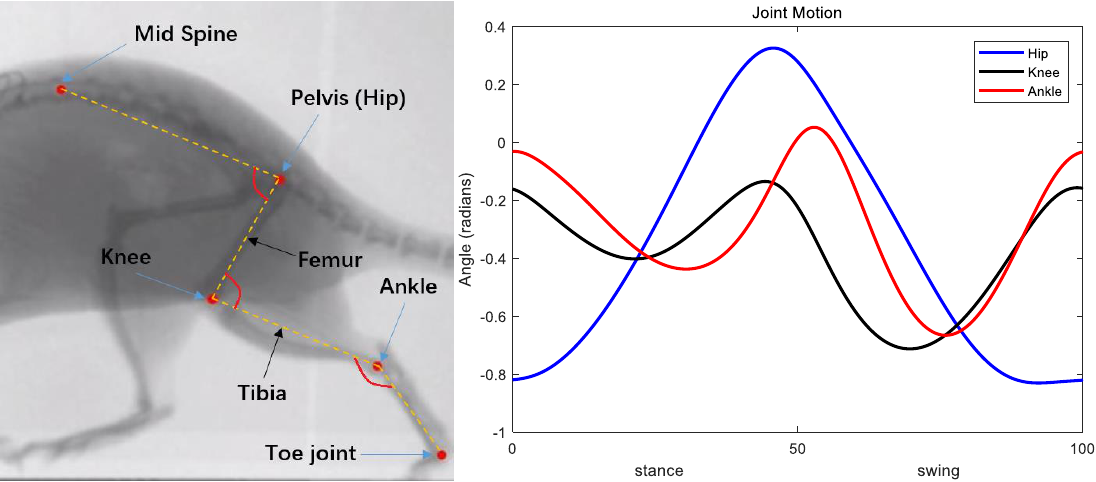
Figure 12. Rat left hindlimb schematic and joint motion. The ankle and the knee motion rhythms are similar, but the timing and the magnitude are different.